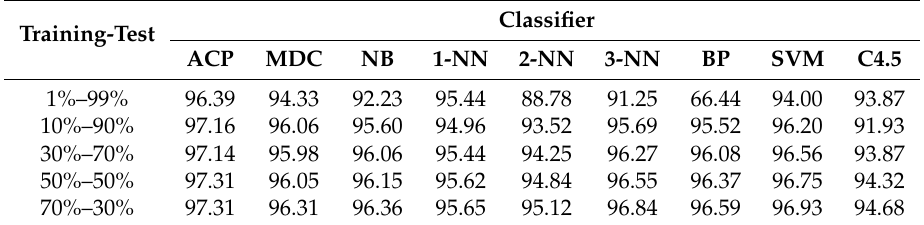
Table 2. Summary of holdout classification.